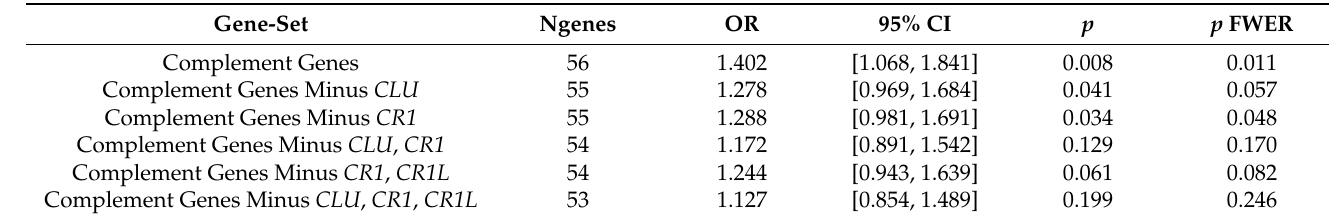
Table 2. Complement gene-set